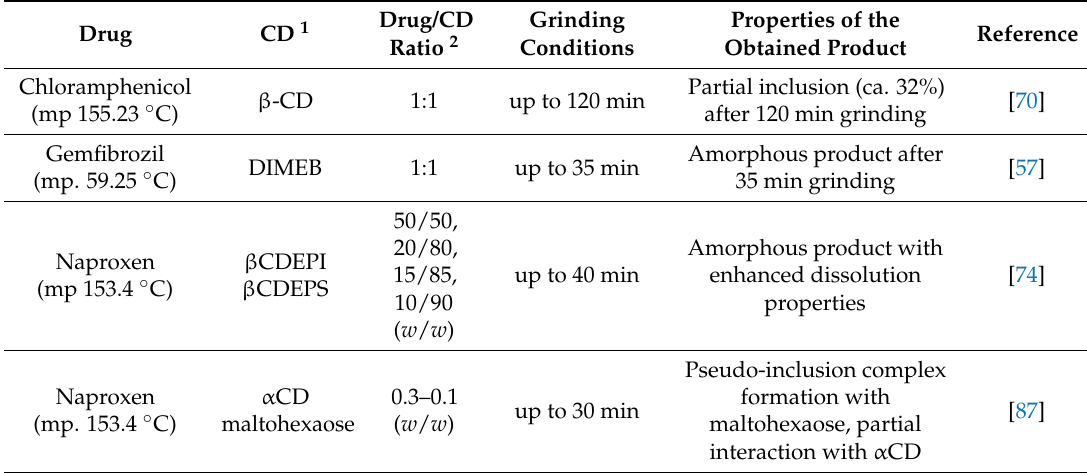
Table 1. An overview of drug/CD complexes prepared by manual grinding using mortar and